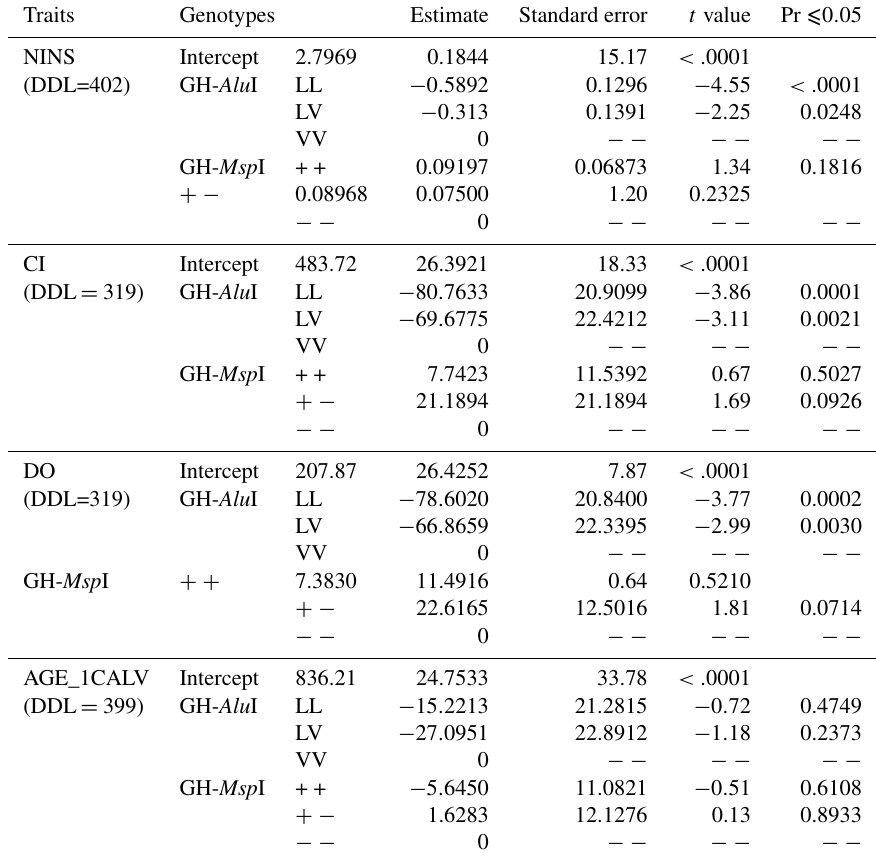
Table 5. Association of GH- Alu I and GH- Msp I genotypes with reproduction trait. DDL refers to degrees of freedom, and Pr refers to probability.